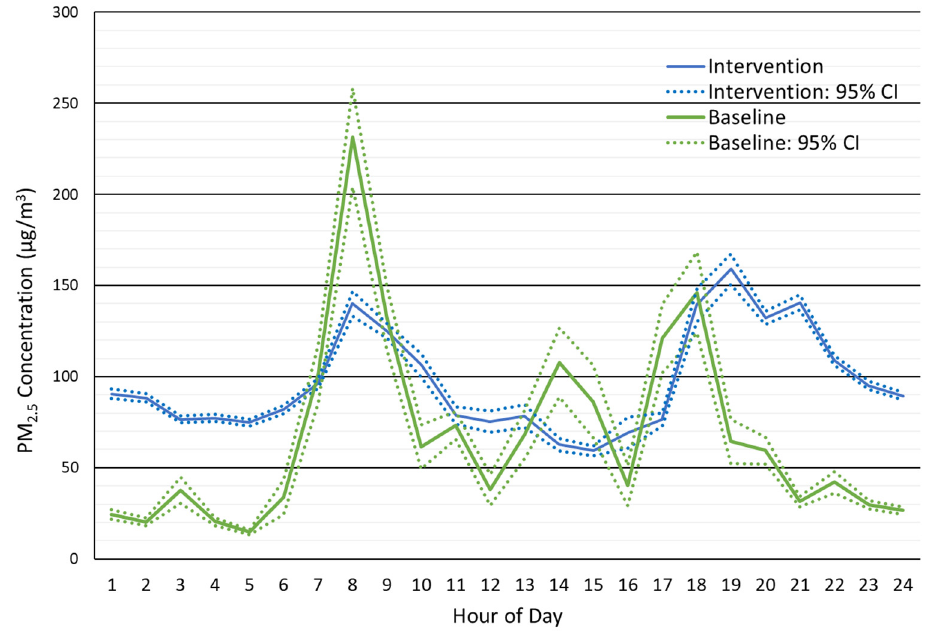
Figure 2. Hourly PM 2.5 concentrations measured during the baseline and intervention phases. Mean and 95% confidence intervals are shown.